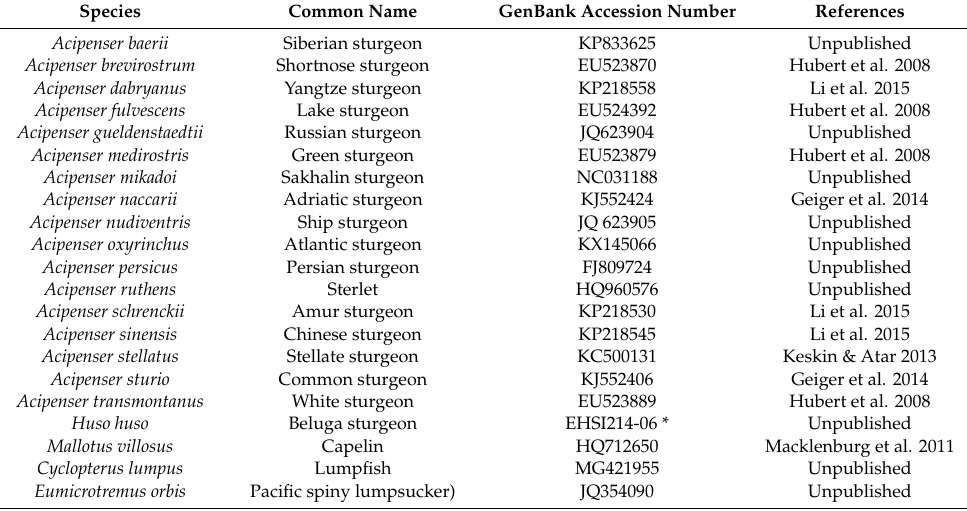
Figure 1. COI-neighbor-joining (CO-NJ) dendrogram showing the relationship of unknown sample sequences (X) to validated reference barcode sequences. The numbers above the nodes represent bootstrap analysis after 1000 replicates. Table 1. GenBank accession numbers of the reference caviar and substitute fish species COI sequences.